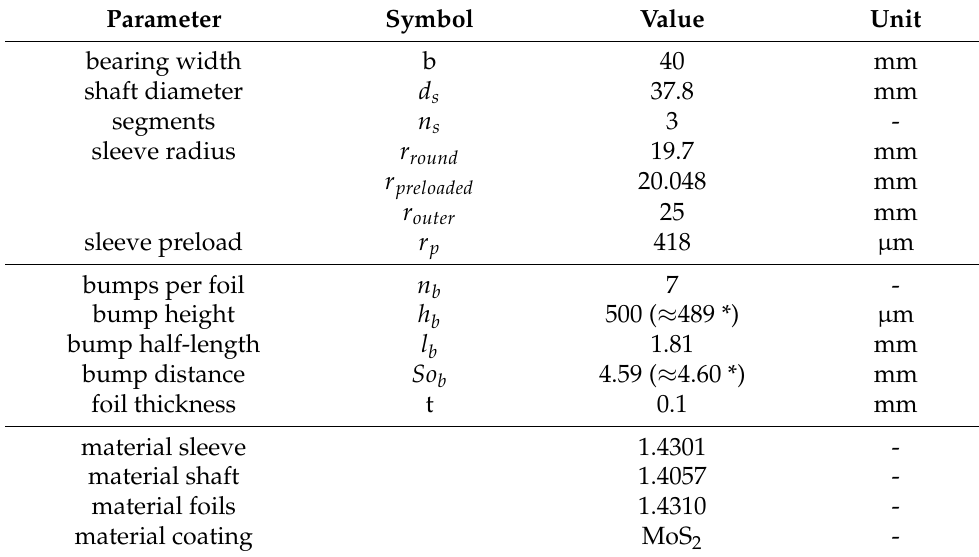
Figure 2. The test bearing used in this study. ( a ) Draft of the two shapes with roman numerals to distinguish the segments; ( b ) bearing with sleeve type A after the first measuring series and with the location of the Pt100 temperature sensor. Table 1. Nominal and measured (*) parameters of the used